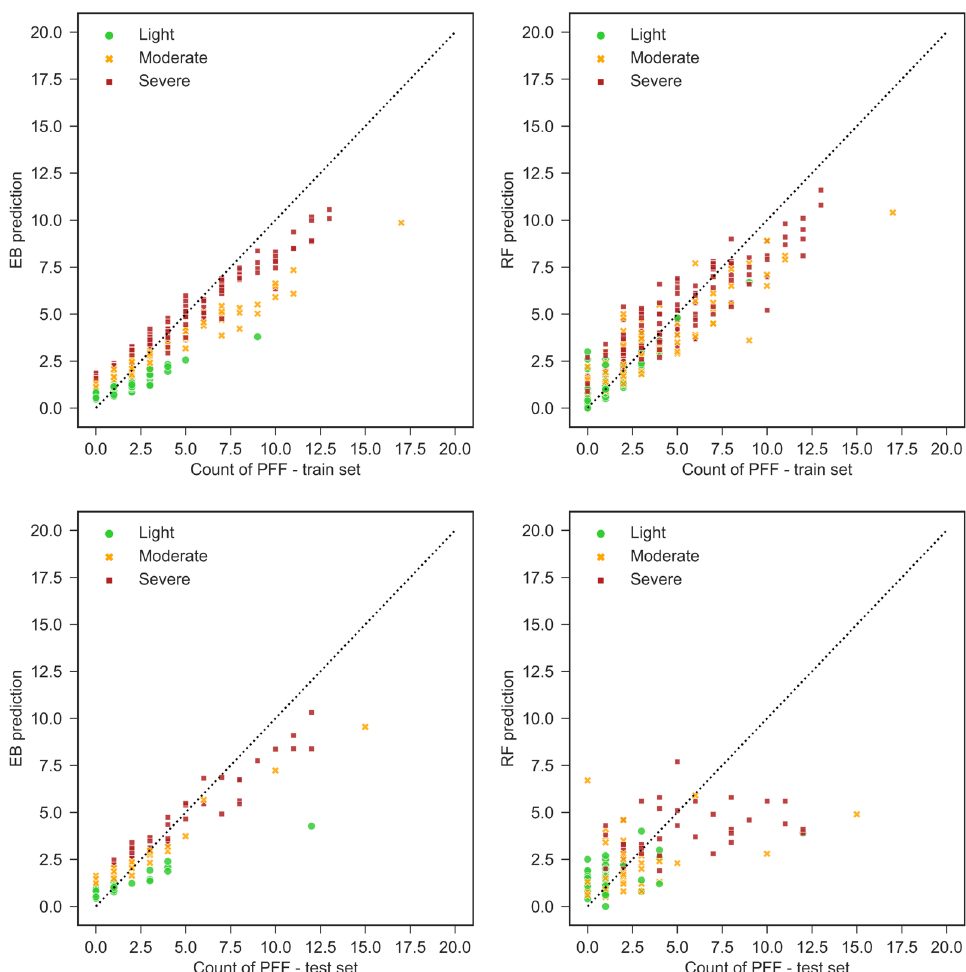
Figure 12. Prediction of the number of roadway PFF